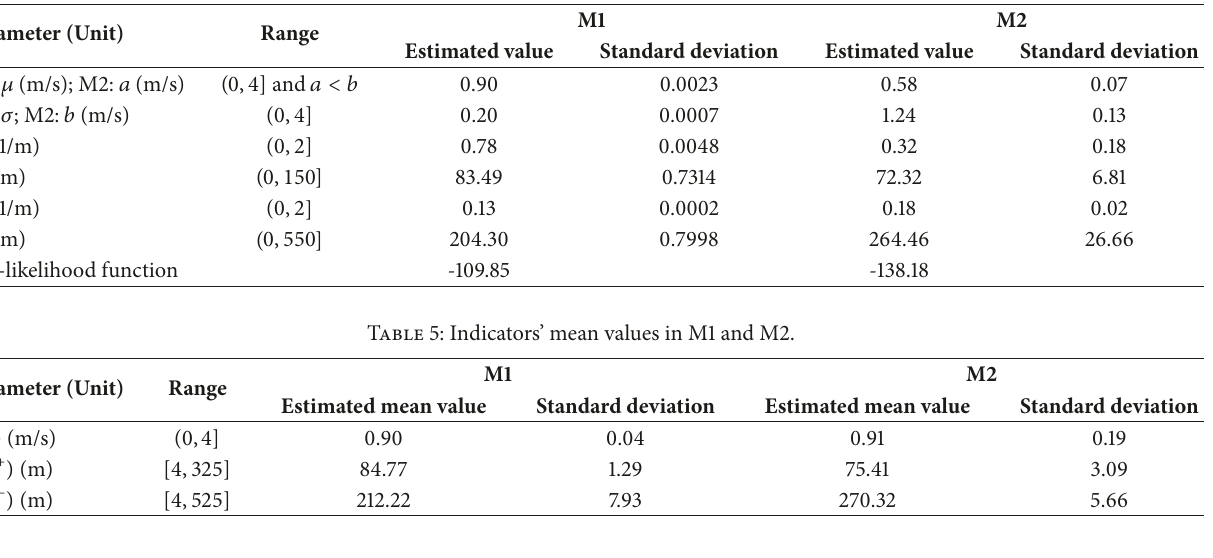
Table 4: Estimated parameters’ values by MLE in M1 and M2.